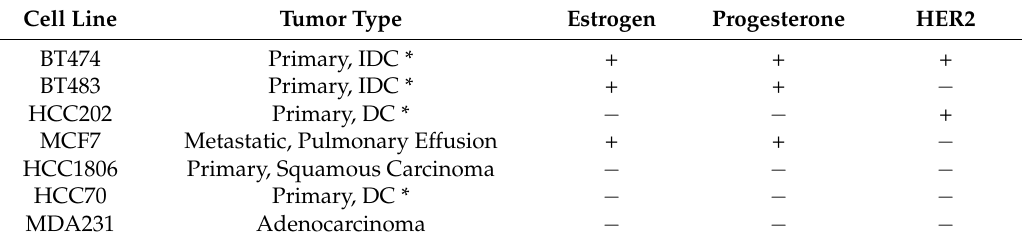
Table 1. Breast cancer cell lines interrogated for CD47